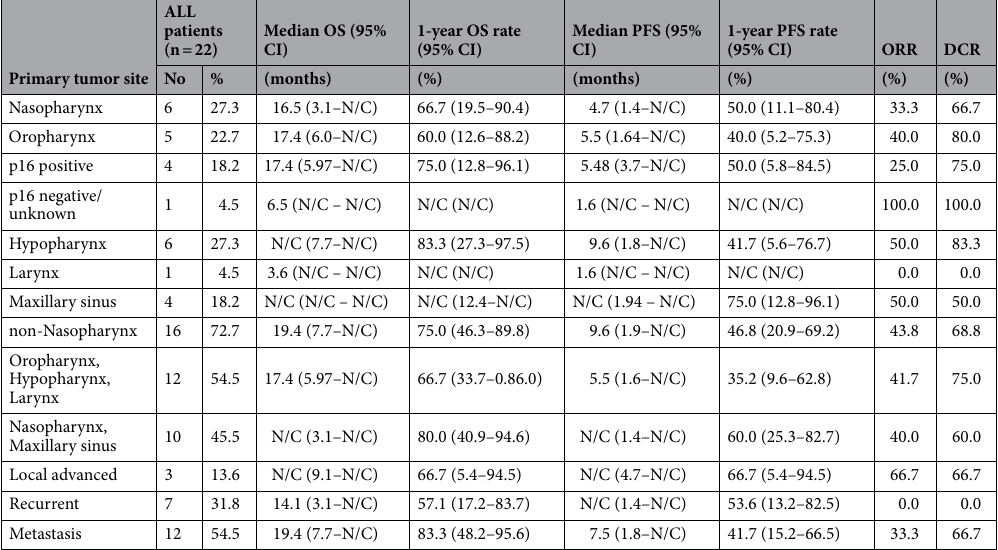
Table 3. Efficacy by primary tumor site.